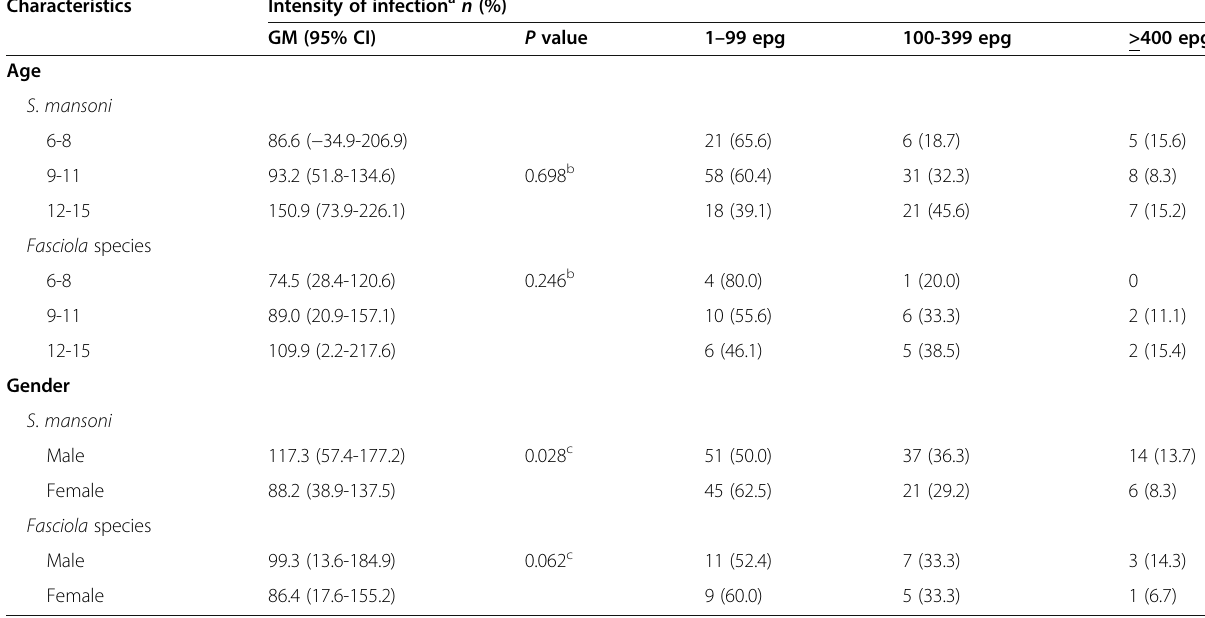
Table 3 Intensity of S. mansoni and Fasciola species infections by age and gender among the school children in Amhara Regional State, Ethiopia